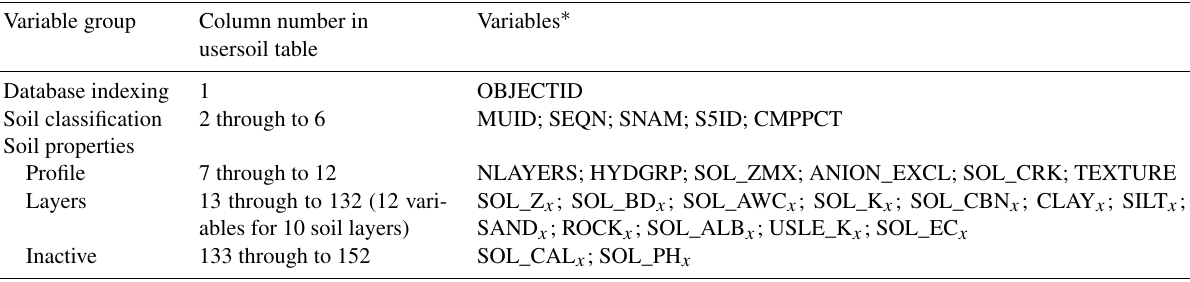
Table (SNT) and respective number of layers in the Soil Layer Table